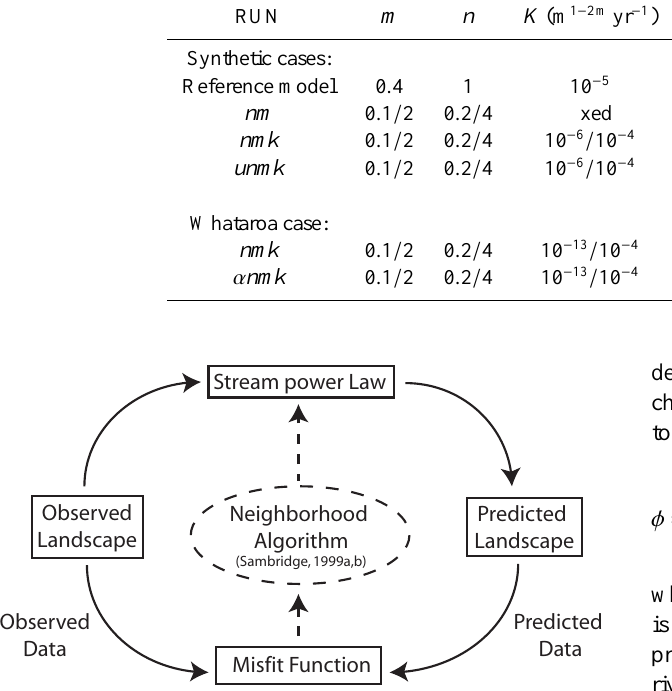
Figure 1. Scheme for the inversion. Observed landscape is ex- tracted from a DEM or obtained by running the SPM to steady state. The predicted landscape is obtained by running the SPL with known parameter ( U , K , m and n ) values selected by the NA in order to minimize the misfit function obtained by comparing the observed and predicted